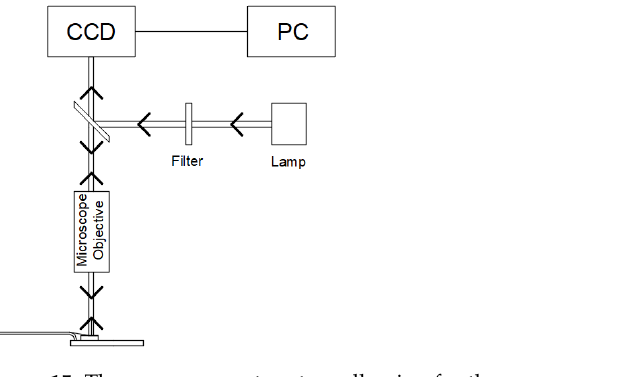
Figure 15. The measurement system allowing for the measurement of surface temperature based on the dependence of reflectance coefficient on temperature.